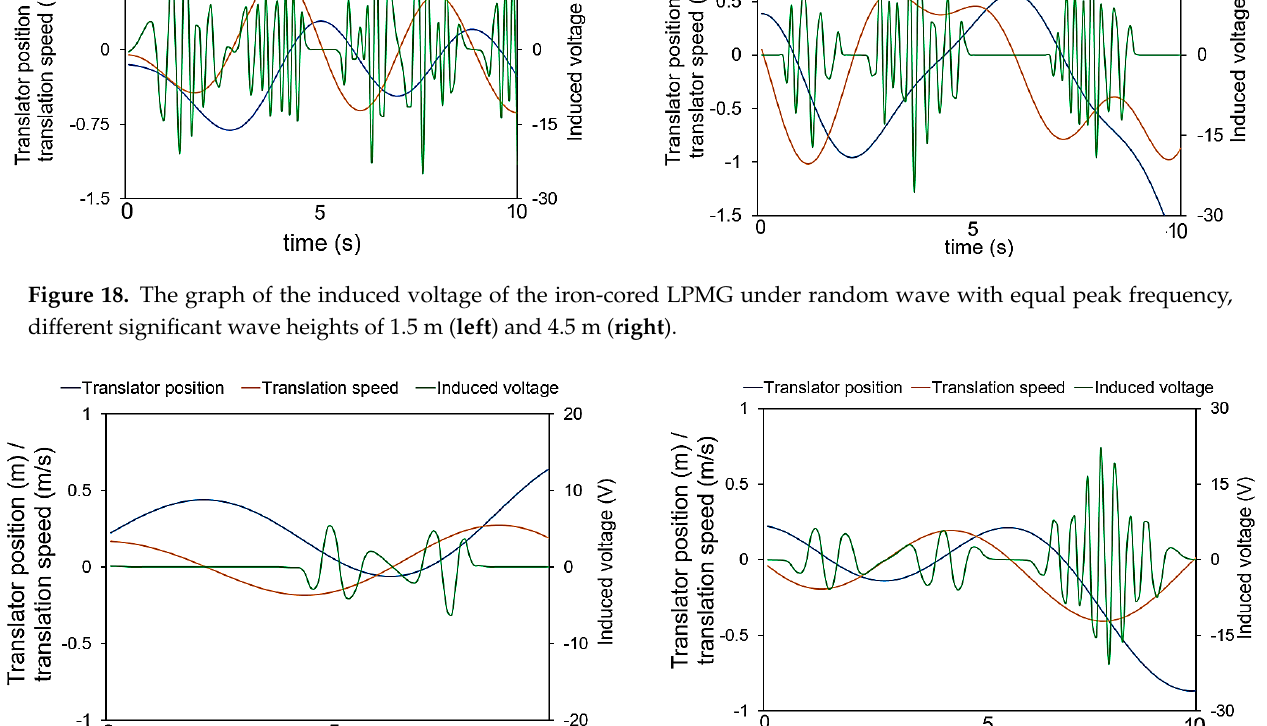
Figure 19. The graph of the induced voltage of the semi iron-cored LPMG under random wave with equal significant wave height, different peak frequencies of 0.83 Hz ( left ) and 0.61 Hz ( right ).